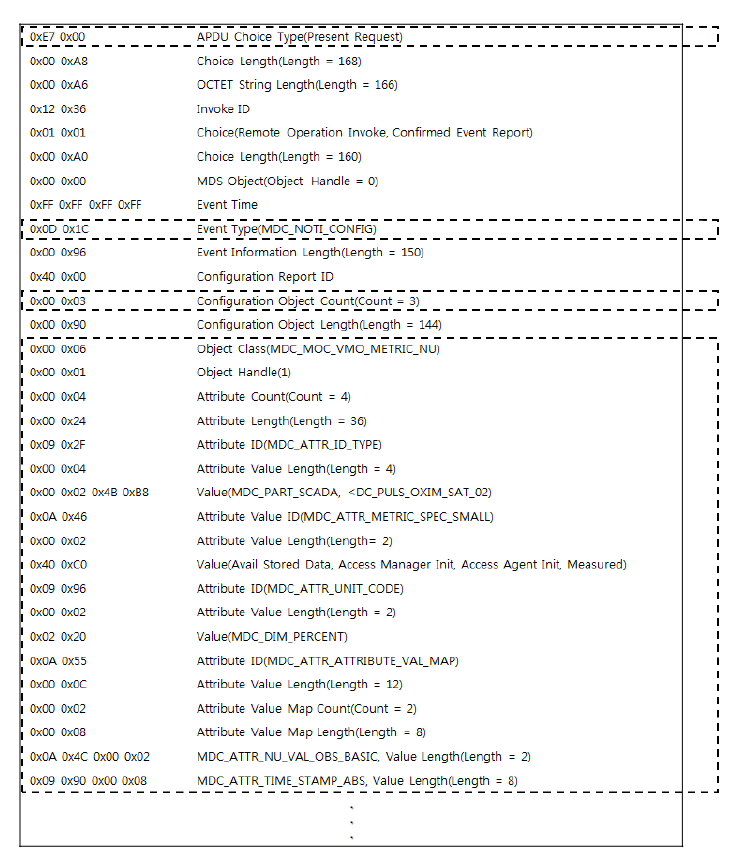
Figure 8. Conversion of an ISO/IEEE 11073 Present (Notice Configuration) Request message to oneM2M Create primitive Request messages.